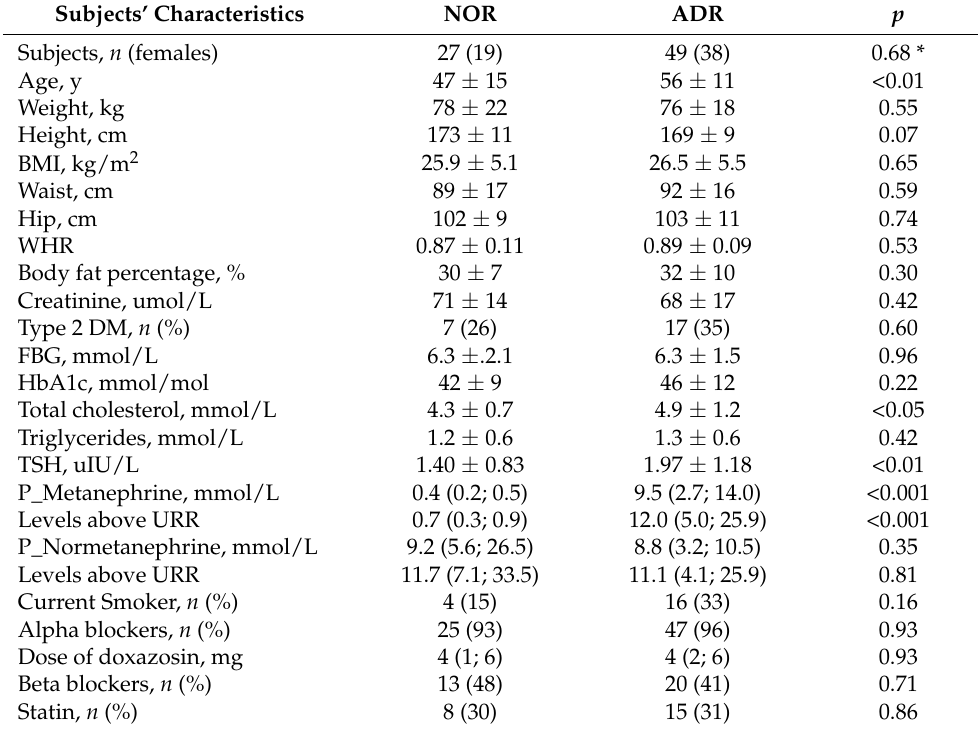
Table 5. Basic characteristics of subject with hypermetabolism according to catecholamine phenotype.